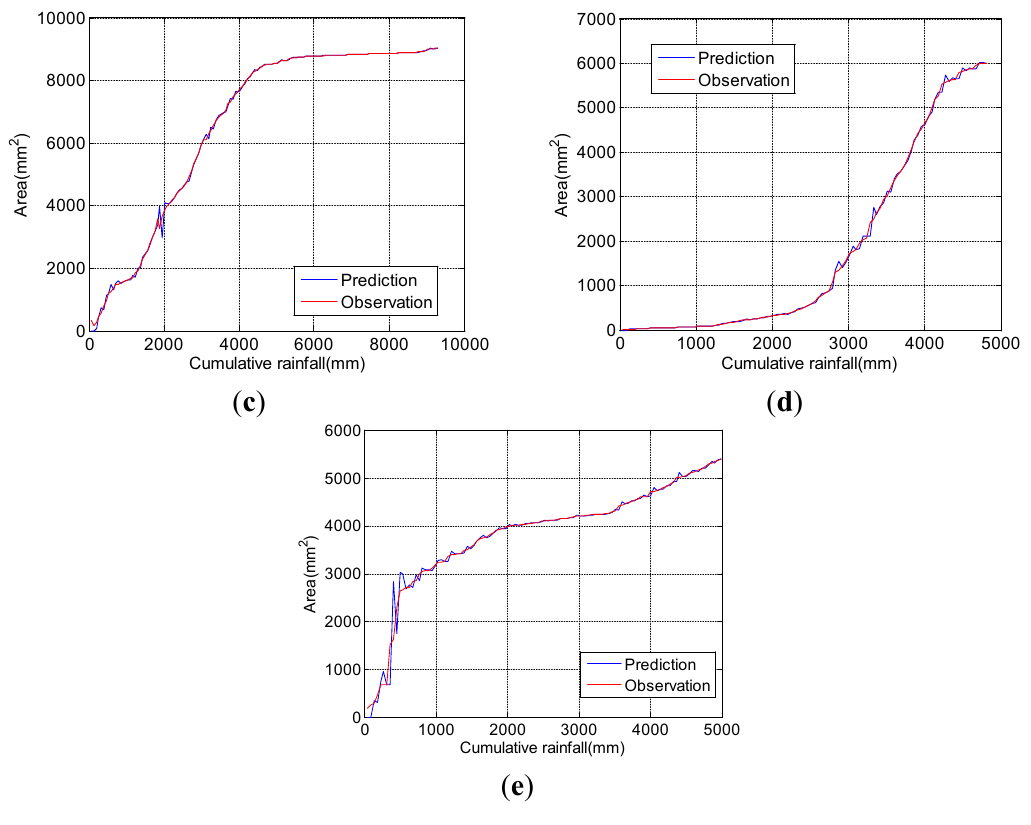
Figure 13. Prediction of model: ( a ) soil Sample 1-25 mm/h ( n = 174); ( b ) soil Sample 1-45 mm/h ( n = 171); ( c ) soil Sample 1-65 mm/h ( n = 142); ( d ) soil Sample 2-45 mm/h ( n = 107); and ( e ) soil Sample 3-45 mm/h ( n =